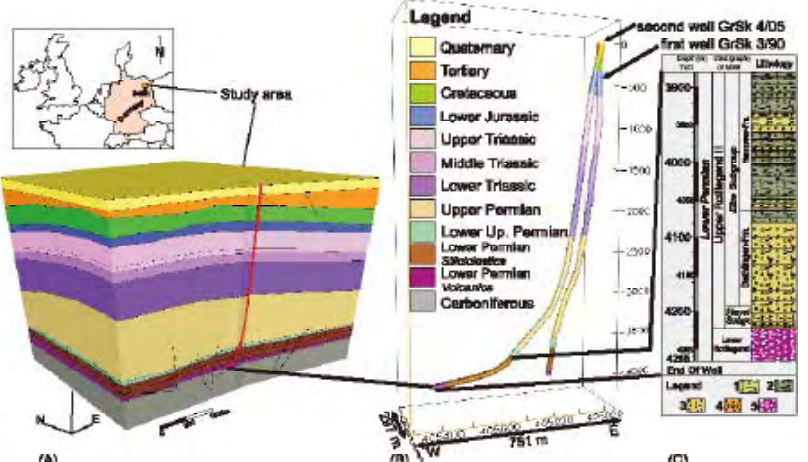
Figure 1. Location of the drilled doublet system and the geothermal aquifer in the Lower Permian of the northeast German Basin. [A] 3-D model showing the geological environment